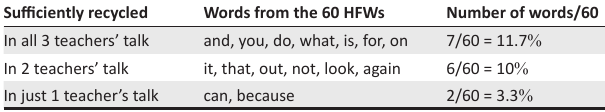
TABLE 3: Part of 60 high-frequency words recycled in at least four of the nine intervals.